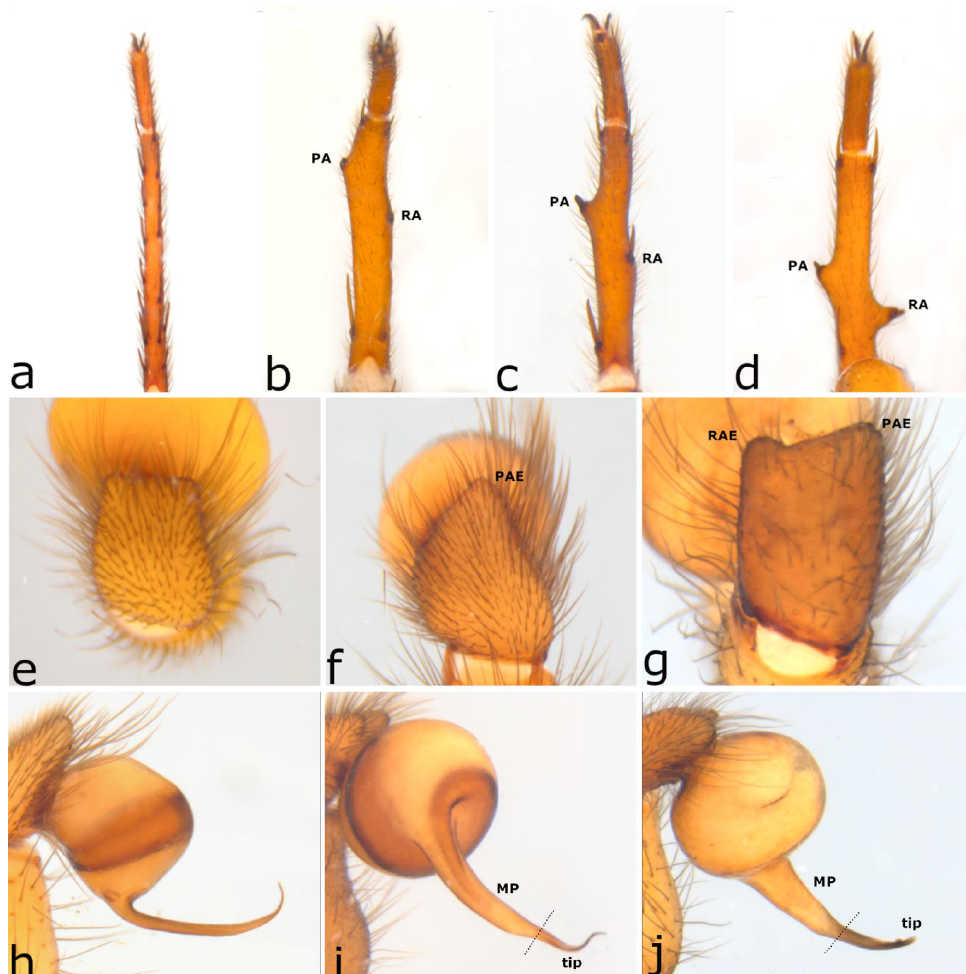
Figure 3. Summary of key diagnostic features for species delineation of male Ariadna : ( a ) metatarsus I A. otwayensis sp. nov., no apophyses; ( b ) same, A. subplana sp. nov., two reduced apophyses; ( c ) same, A. inflata sp. nov., two apophyses, one reduced, one prominent; ( d ) same, A. propria sp. nov., two prominent apophyses; ( e ) left pedipalp cymbium A. propria sp. nov. blunt apically, with no obvious PAE or RAE; ( f ) same, A. otwayensis sp. nov. PAE prominent, RAE highly reduced; ( g ) same, A. umbra sp. nov. PAE and RAE prominent; ( h , i ) details of embolus in ( h ) A. sinuosa sp. nov., ( i ) A. formosa sp. nov. and ( j ) A. umbra sp. nov.; the relative location of the transition from the mid portion (MP) to tip, indicated by a dashed line ( i , j ).